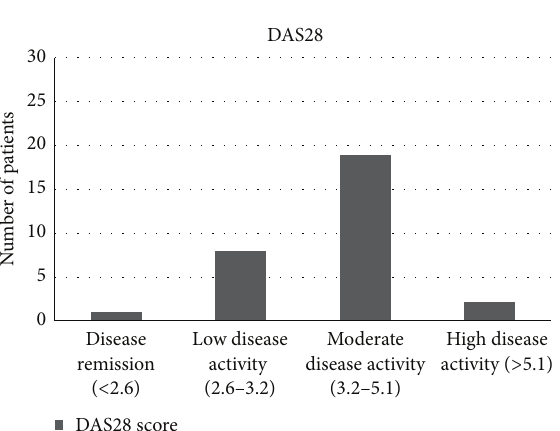
Out of 182 joints with abnormal synovial hypertrophy, 71 (39.01%) were MCP, 69 (37.91%) were PIP, and 42 (23.07%) were DIP joints. Thus, more synovial hypertrophy was